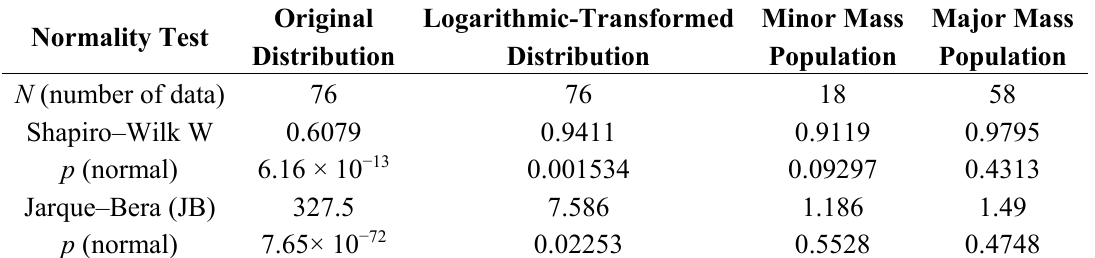
Table 2. Results of Shapiro–Wilk and Jarque–Bera normality